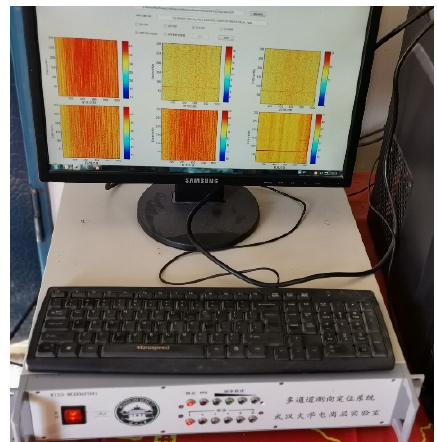
Figure 4. The control part of the upper computer.